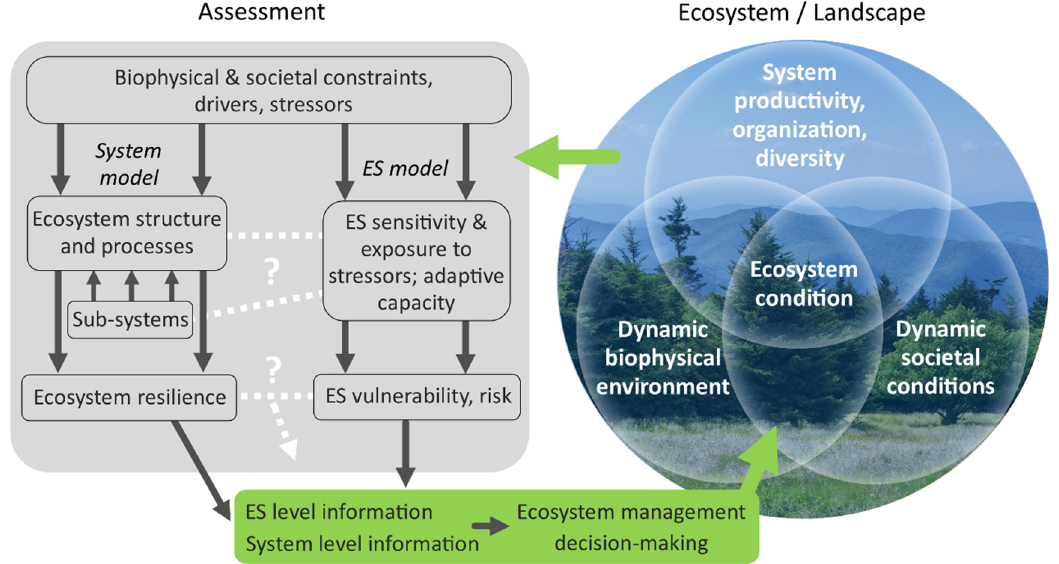
Figure 1. Representation of ecosystems and ecosystem services (ES) in ecological assessment frameworks. The capacities of ecosystems to support ES vary in response to environmental and societal conditions. These dynamics are represented in different ways by system-oriented assessment models and ES-oriented models. Assessments that quantify ecological effects, feedbacks, and other functional linkages between these different levels of organization, treating ES as integral system components, are uncommon (suggested by dashed white lines). Integrative assessments can aid ecosystem management by providing knowledge about dependencies in the ways various system processes and ES respond to environmental change and management actions.